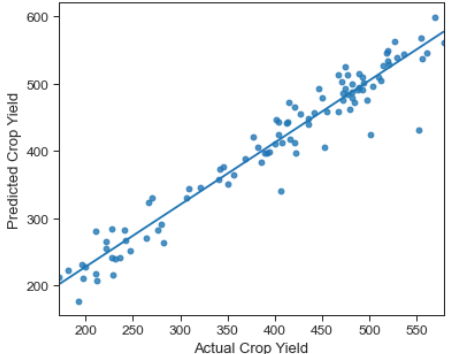
Figure 20. Relationship between actual and predicted crop yields on a